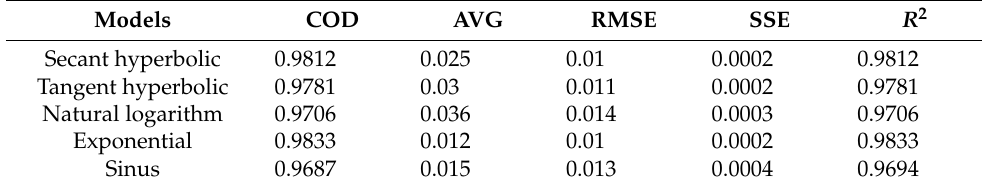
Table 8. Precision and performance of models for CSR prediction (training data).